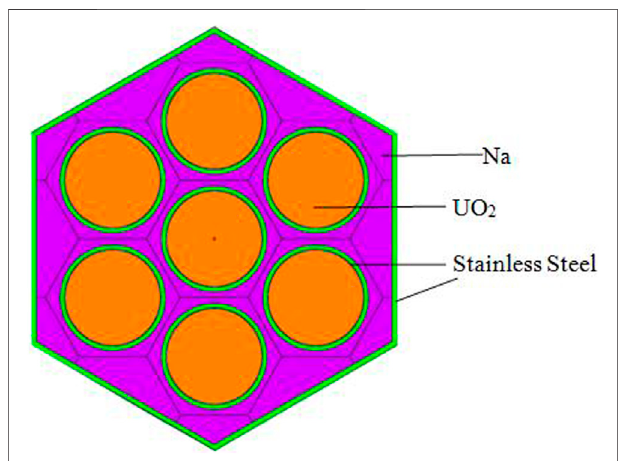
FIGURE 4 | Structure of the fuel assembly of FPPRU1 and